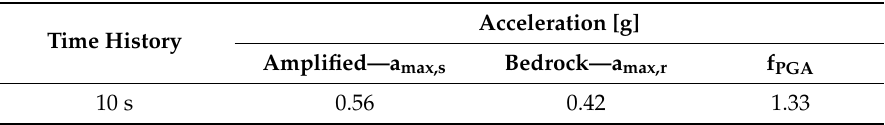
Table 5. Amplification factor based on time domain.